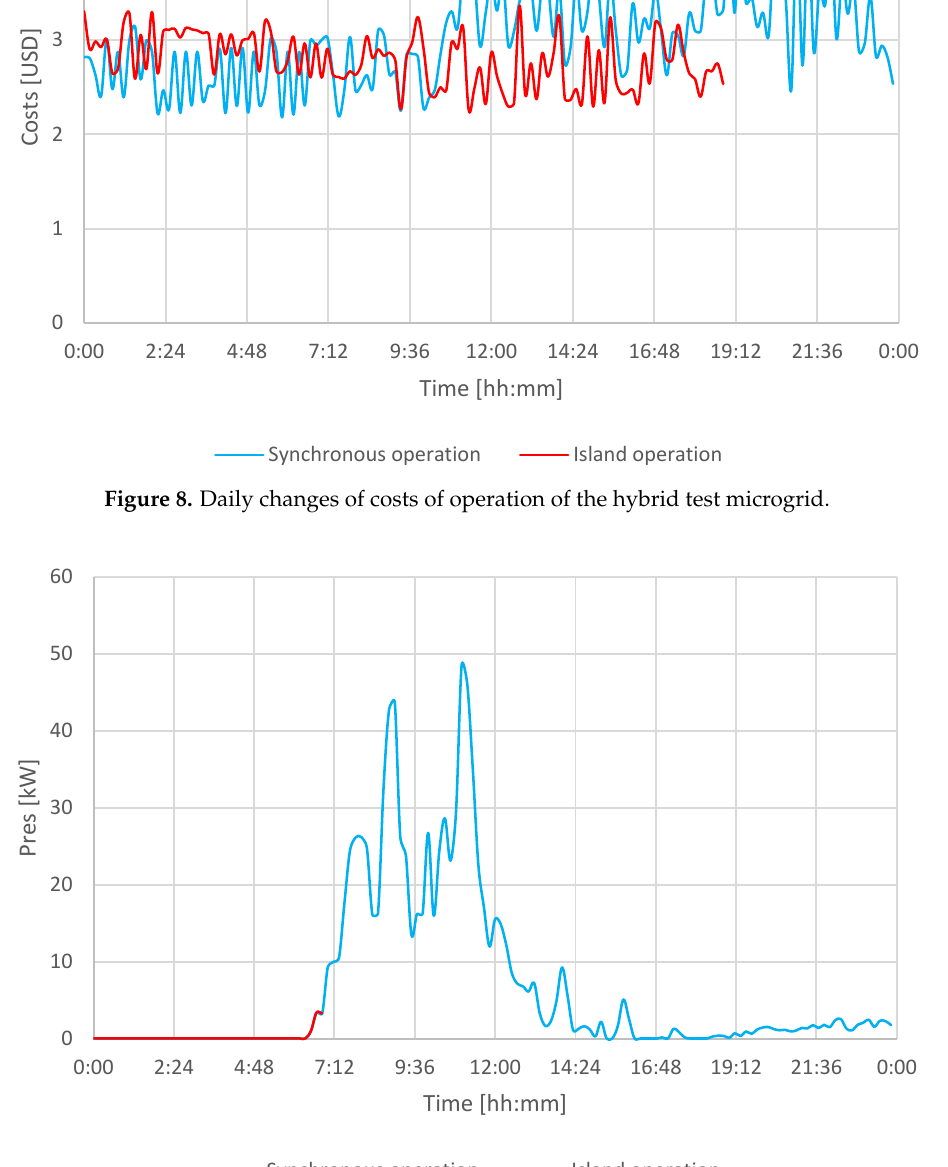
Figure 9. Daily changes of active power generated in RES.